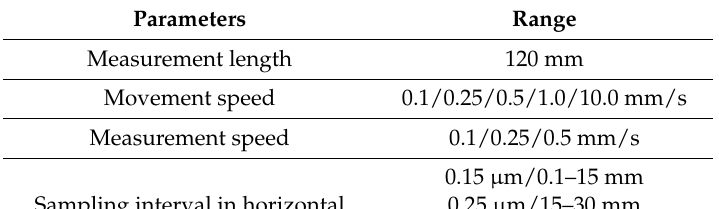
Table 3. Detailed parameters of PGI 840 roughmeter.